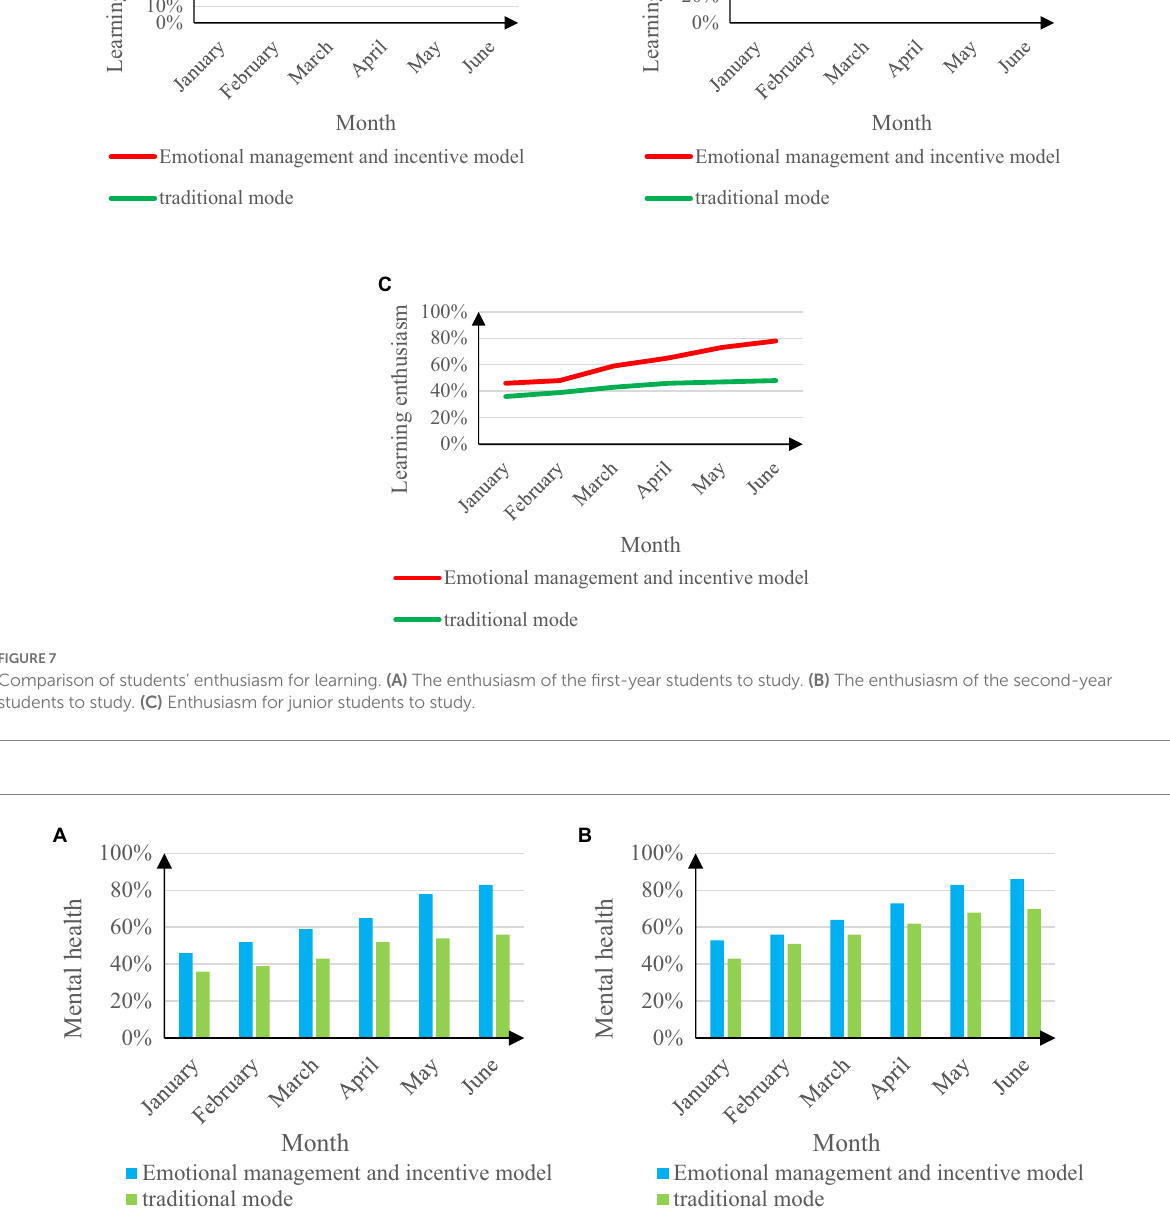
FIGURE 8 Comparison chart of students’ mental health. (A) Mental health of female students. (B) Mental health of male